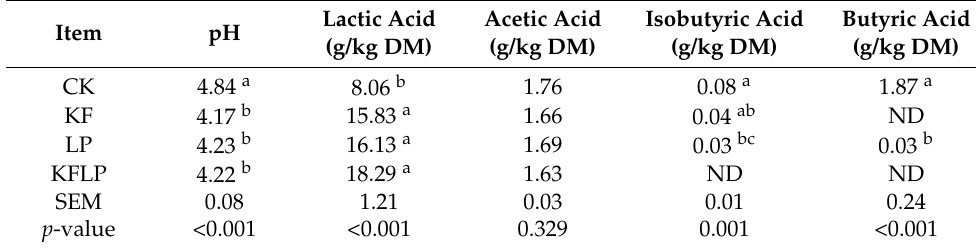
Table 1. The pH and organic acid contents of forage rape silages were fermented with KF and LP for 60 days.